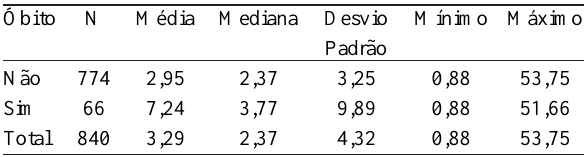
Tabela 6. Comparação da média do EuroSCORE logístico entre